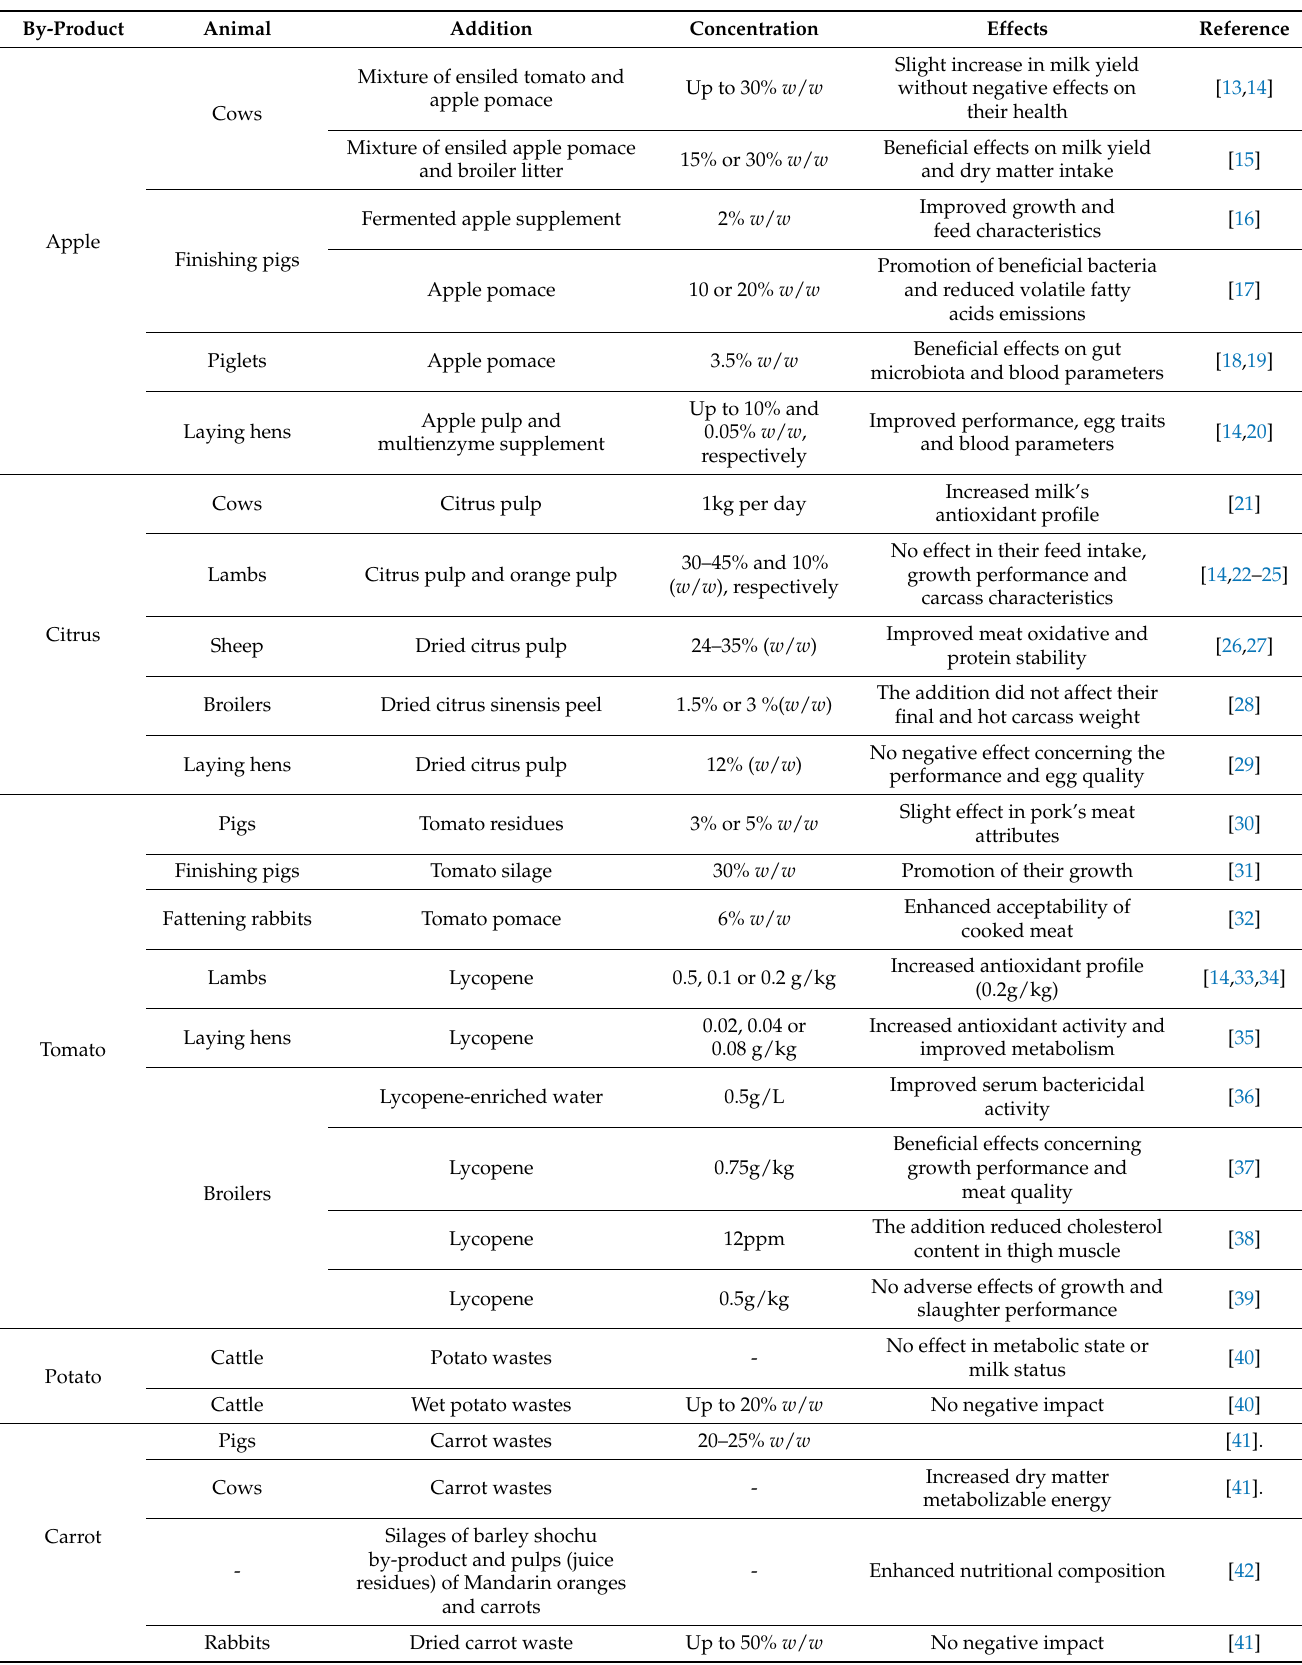
Table 1. Addition of agri-food by-products to